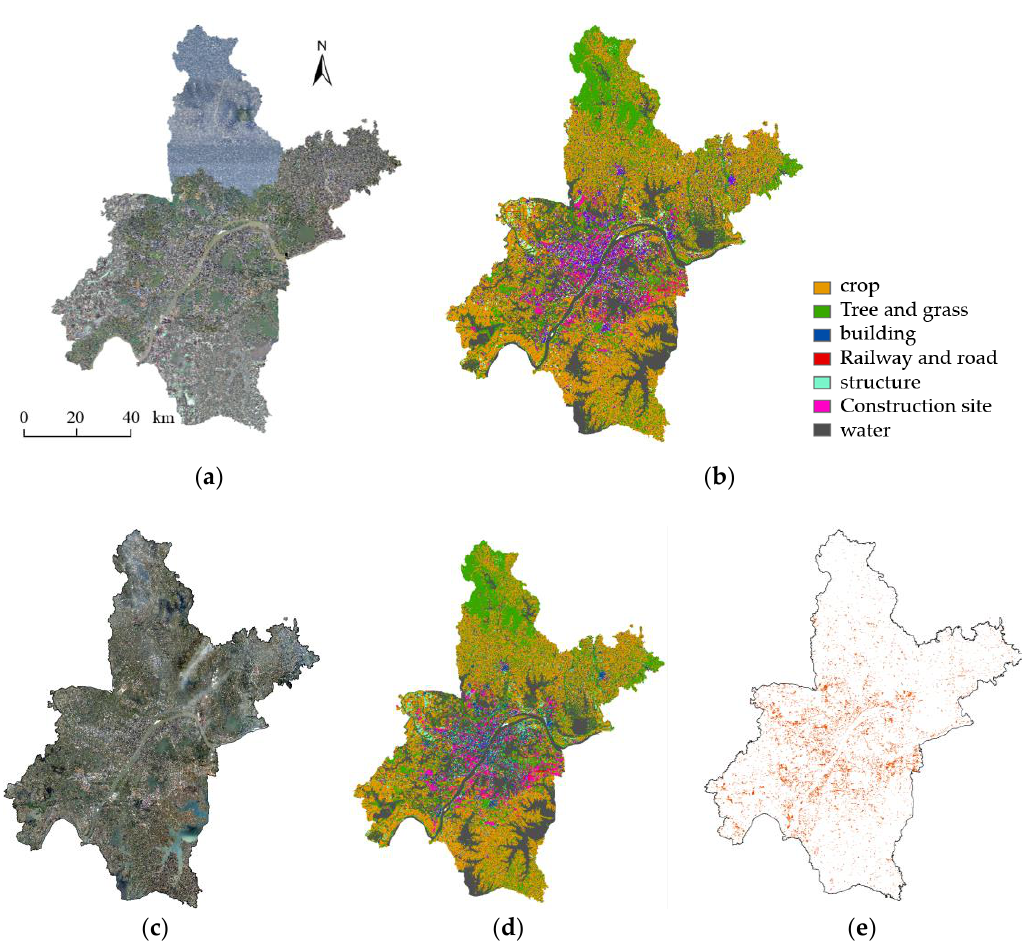
Figure 4. The 2014 Wuhan aerial images covering 8000 km 2 with 0.5 m ground resolution ( a ) and the corresponding land cover GIS map ( b ). The 2017 Beijing-2 satellite images with 1 m ground resolution ( c ) and the corresponding land cover GIS map ( d ). ( e ) is the ground truth of change map produced from comparing Figure 1b and Figure 1d.